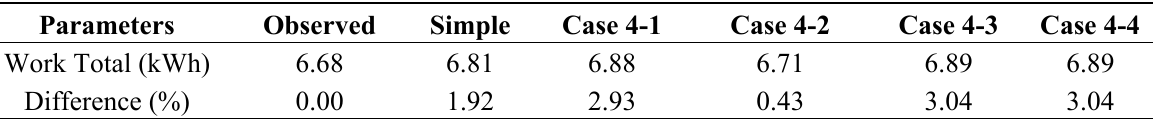
Figure 5. ( a ) Thermal storage temperature and ( b ) shaft power for the actual weather conditions, the simple sky model and the proposed model. Table 3. Daily work total and its differences between the results of observed data and the others. Parameters Observed Simple Case